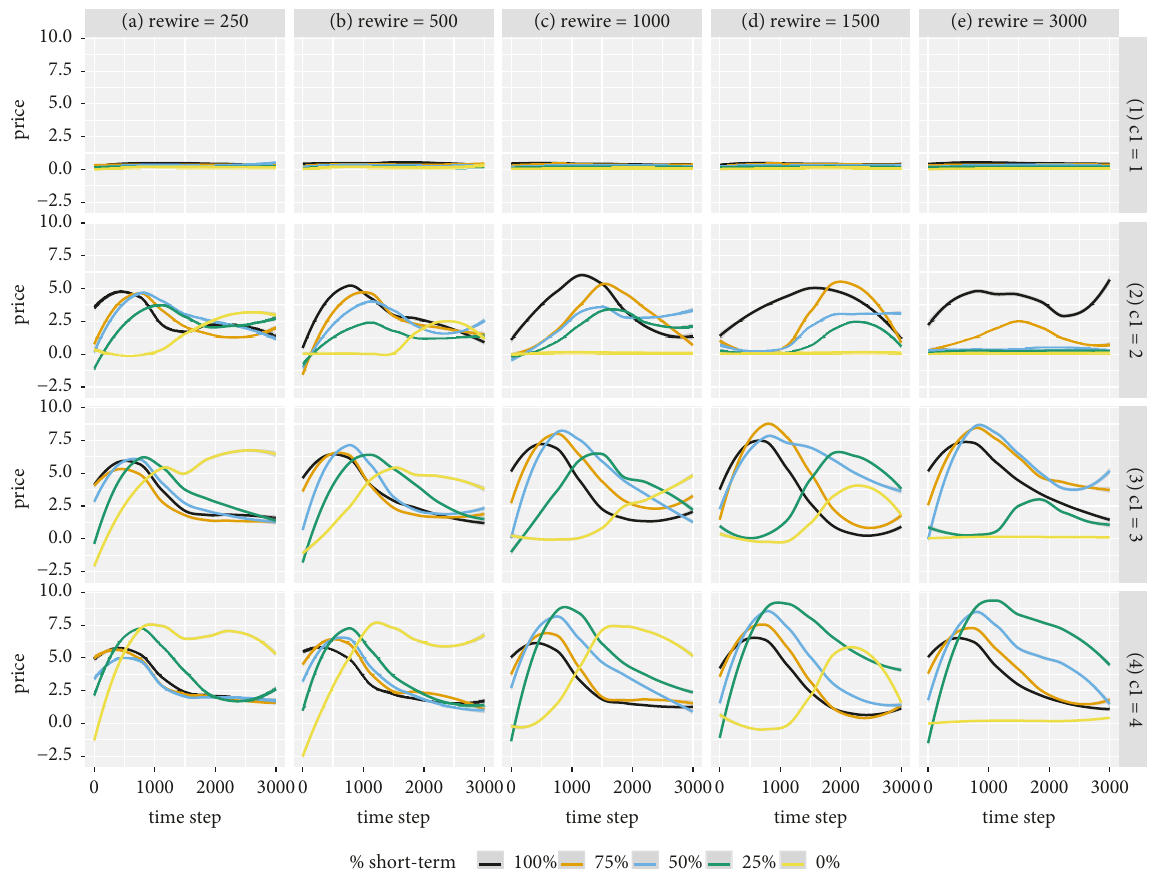
Figure 4: Temporal behavior of the risky asset’s price with rewiring introduced. Facets now differentiate for the rewire and c 1 variables. The lines are prepared by applying a LOESS and represent the progression of the asset’s price for the various combination of short- and long-term